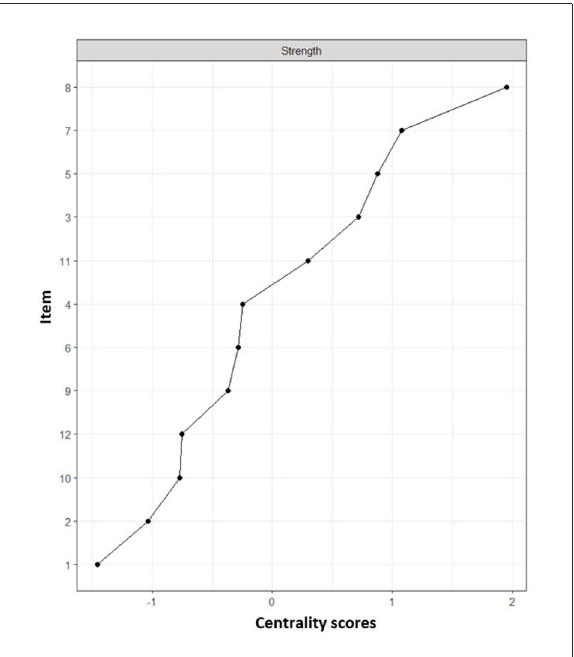
FIGURE2 Centrality indexes of chronic conditions. Centrality refers to the measure with the highest number of connections together with the sum of the relationships it presents. Numbers refer to a chronic condition identified in Table 3. (1) Arthritis, (2) Obesity, (3) Diabetes, (4) Kidney disease, (5) High blood pressure, (6) High blood cholesterol, (7) Heart attack, (8) Coronary heart disease, (9) Asthma, (10) Stroke, (11) Respiratory diseases, (12) Depression.